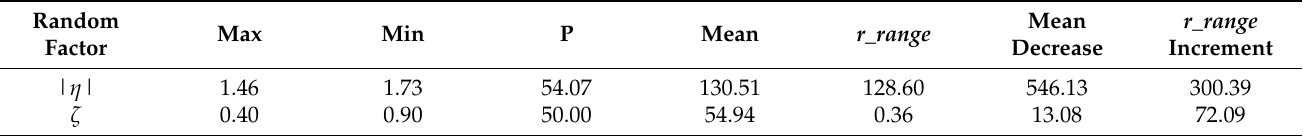
Table 4. Property comparison of ζ and | η | properties before and after the restriction.